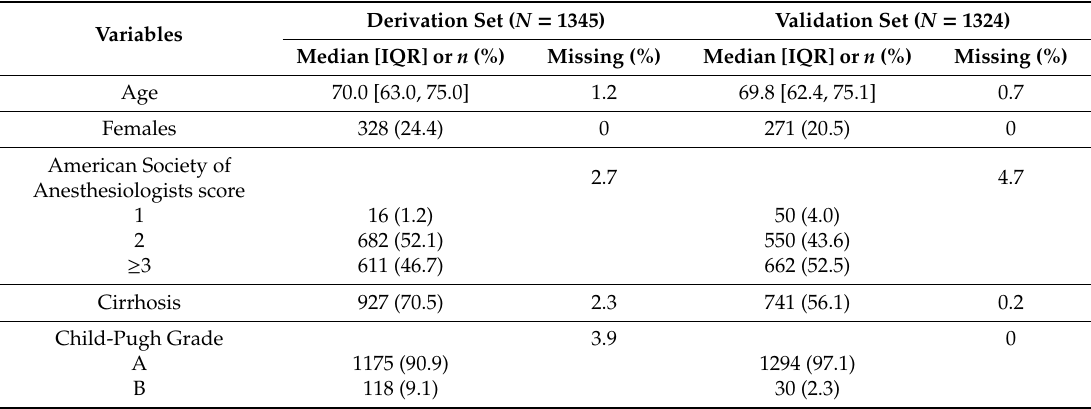
Table 1. Characteristics of the derivation and validation